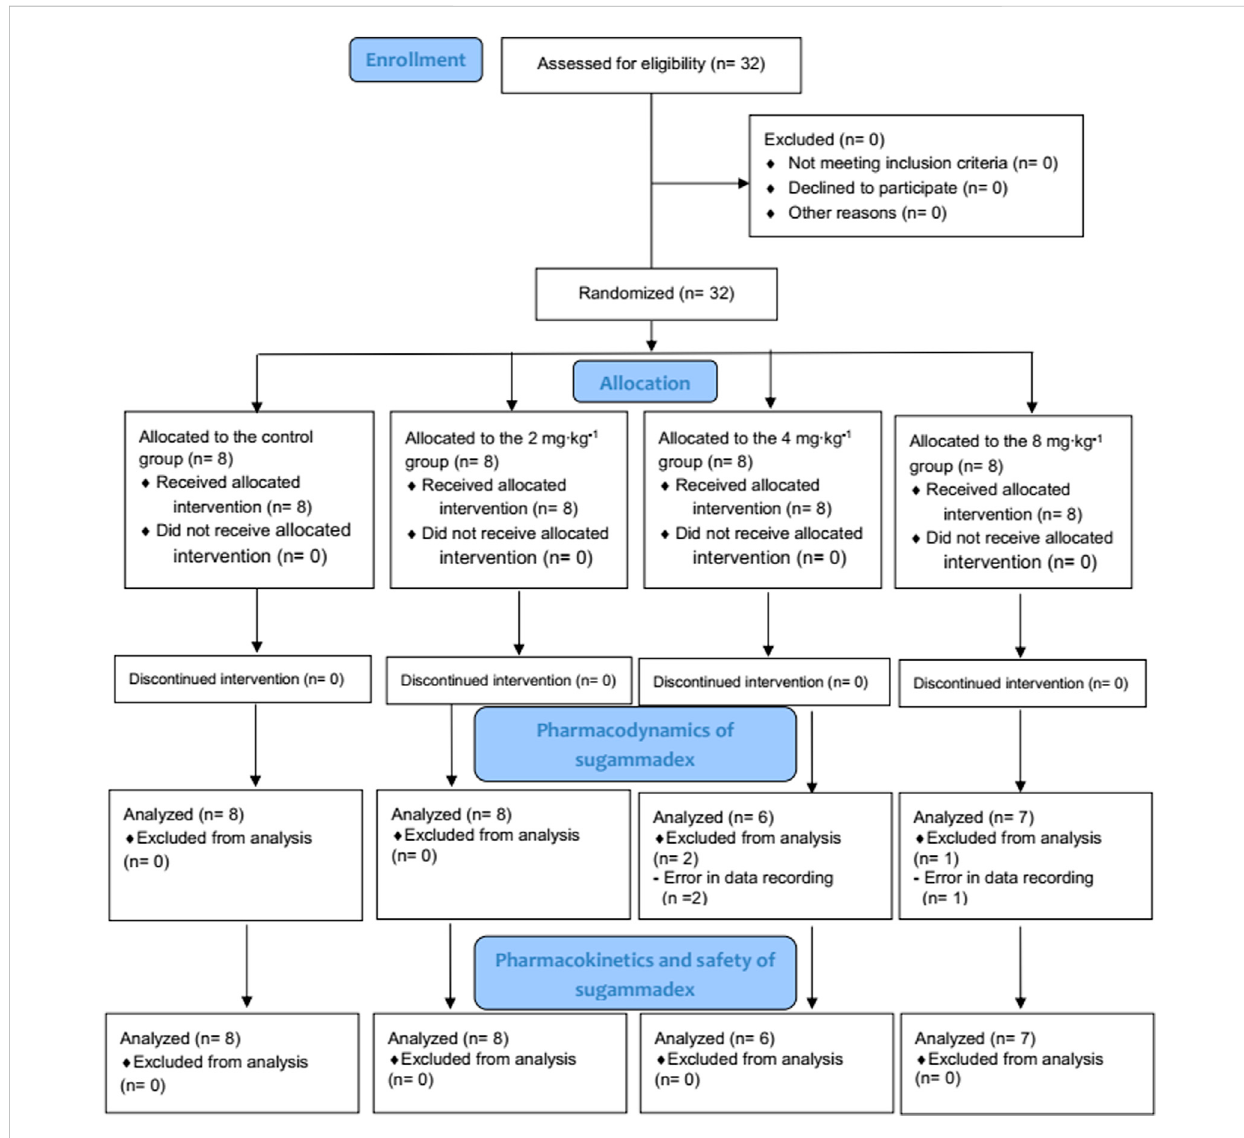
FIGURE 1 Consolidated Standards of Reporting Trials (CONSORT) fl ow